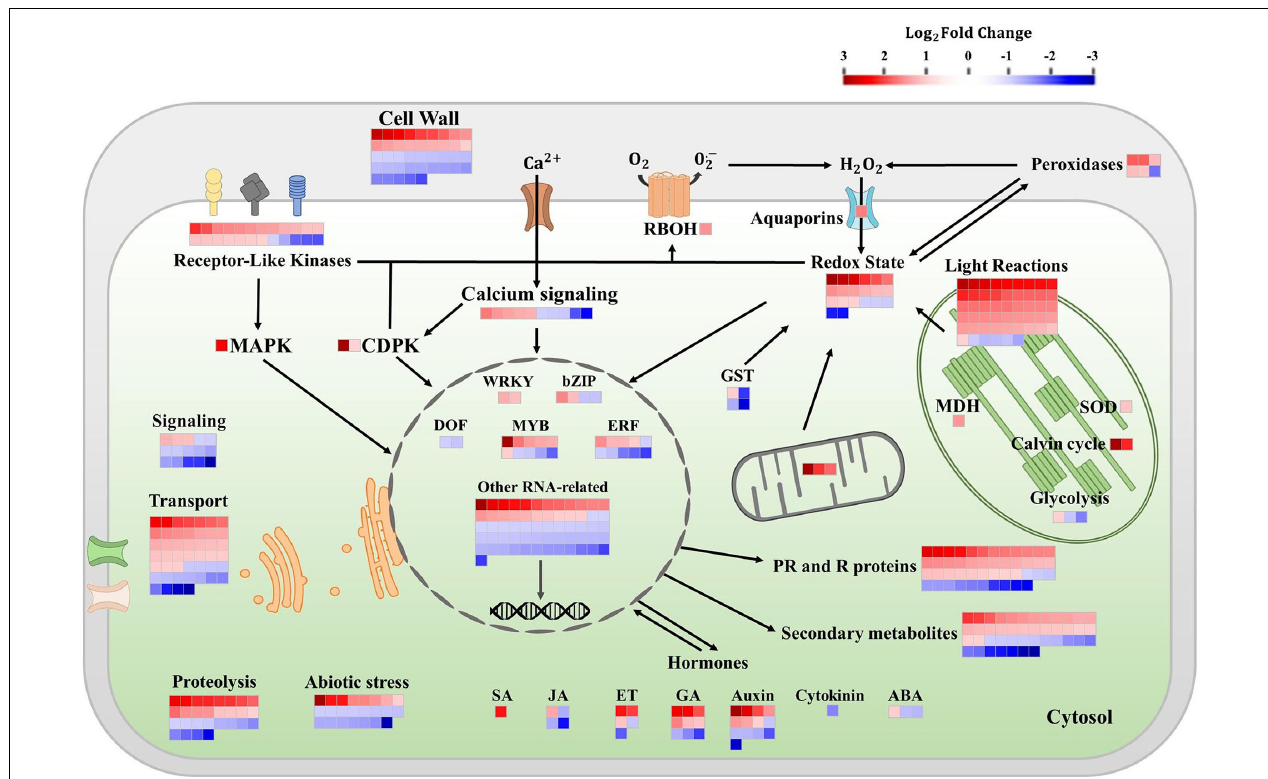
FIGURE 1 | Differentially expressed genes from selected pathways in tomato leaves after three sprayings with chitooligosaccharides–oligogalacturonides (COS-OGA; 62.5 mg/l; based on MapMan). Tomato leaves were harvested 24 h after the third treatment. Represented genes show a significant change in expression [false discovery rate (FDR) < 0.05; | log 2 Fold Change| > 1]. Each square corresponds to log 2 fold change of a transcript in elicited versus control samples. Squares are colored in red and blue if they are classified as upregulated and downregulated, respectively. The names of the genes and their relative expression levels are given in Supplementary Table 1 . ABA, abscisic acid; bZip, basic leucine zipper domain; CDPK, calcium-dependent protein kinase; DOF, DNA-binding with one finger; ERFs, ethylene responsive factors; ET ethylene; GA, gibberellic acid; GST, glutathione-S-transferase; JA, jasmonic acid; MAPK, mitogen-activated protein kinase; MDH, NADP malate dehydrogenase; PR, pathogenesis-related; R, resistance; RBOH, respiratory burst oxidase; SA, salicylic acid; and SOD, superoxide